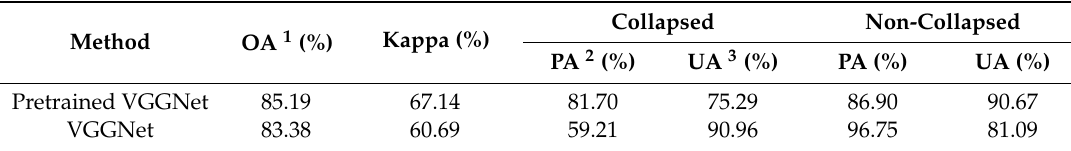
Table 1. Performance of identification of collapsed buildings using Visual Geometry Group (VGG)Net model and fine-tuned VGGNet